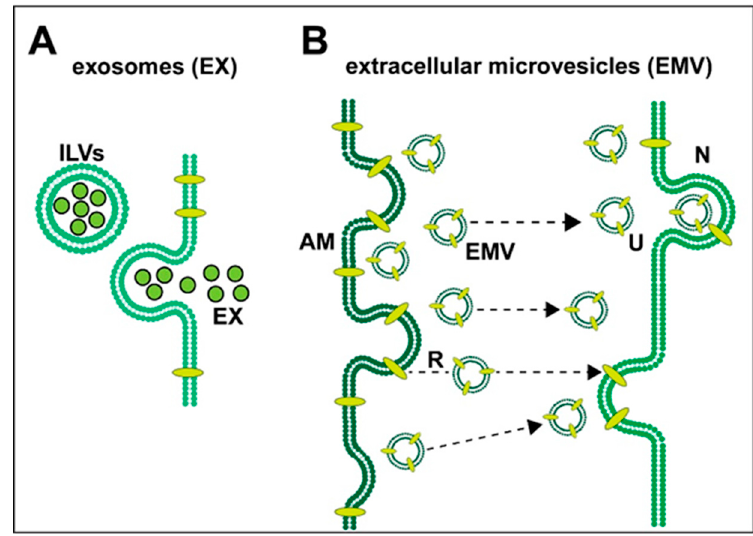
Figure 1. Highly schematized representation of ( A ) the release of exosomes (EXs) and ( B ) the release and uptake of extracellular microvesicles (EMVs) in neural cells of the human central nervous system (CNS); both types of vesicular transport systems have been observed to operate in the brain between astroglial cells and neurons; ( A ) exosomes—when mature intracellular endosomes (also known as multi-vesicular bodies) containing intraluminal vesicles (ILVs; black outlined green spheres) fuse with the plasma membrane and empty their plasma membrane-encapsulated cargo, ILVs are released and, from being extracellular, they become exosomes (EX); these 30–100 nm diameter spheres contain various mixtures of proteins, lipids, proteolipids, cytokines, chemokines, microRNAs (miRNA), messenger RNAs (mRNA) and end-stage neurotoxic metabolic products, including 42 amino acid amyloid-beta (A β 42) peptides, tau proteins and/or the lipid raft associated flotillin (Angelopoulou et al. 2020 [29]; Hornung et al., 2020 [30]); EXs appear to play a central role in the spread of A β 42 pathology and amyloidogenesis (Mathews and Levy 2019 [15]; Arbo et al., 2020 [6]; Peng et al., 2020 [31]); ( B ) extracellular microvesicles (EMVs)—the exterior plasma membrane of activated microglia (AM) can release (R) 100–1000 nm diameter EMVs directly from the outward blebbing of the plasma membrane of microglias and astrocytes and carry intracellular contents from their cells of origin; this includes various complex mixtures of proteins, lipids, proteolipids, miRNAs, mRNAs, end-stage metabolic products and cytokines and chemokines; together these EMV contents may be pathogenic and cause the spread of pro-inflammatory signaling and inflammatory neurodegeneration (Prada et al., 2018 [21]; Serpente et al., 2020 [22]; Vanherle et al., 2020 [4]). Microvesicular trafficking and the extracellular microvesicle uptake (U) by neurons (N) via directed translocation mechanisms (dashed black lines with black arrowheads) may occur via the direct fusion of the EMV membrane with the neuronal cell plasma membrane or by endocytosis (Stahl et al., 2019 [5]; Arbo et al., 2020 [6]; Hornung et al., 2020 [30]; Peng et al., 2020 [32]; Song et al., 2020 [9]; Upadhya et al., 2020 [20]).